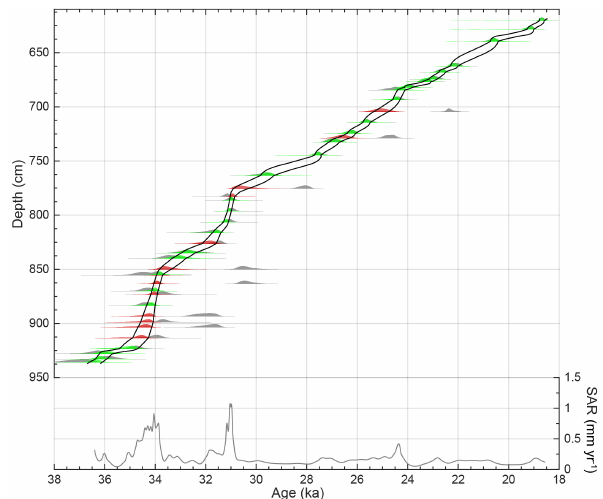
Figure 3. Age model for the sediments at 1st Pond, Nightingale Island. Top plot: radiocarbon-based age–depth model (black lines encompass the 68.2% probability interval). The patches indicate the calibrated probability distributions of each radiocarbon date for un- modeled (single) dates (gray patch) and their posterior distributions when modeled as a P sequence: green patches indicate agreement indices of >60% and red patches agreement indices of <60%, i.e., outliers. Bottom plot: sediment accumulation rates (SAR, mma − 1 ) based on the mean age–depth model shown in the top